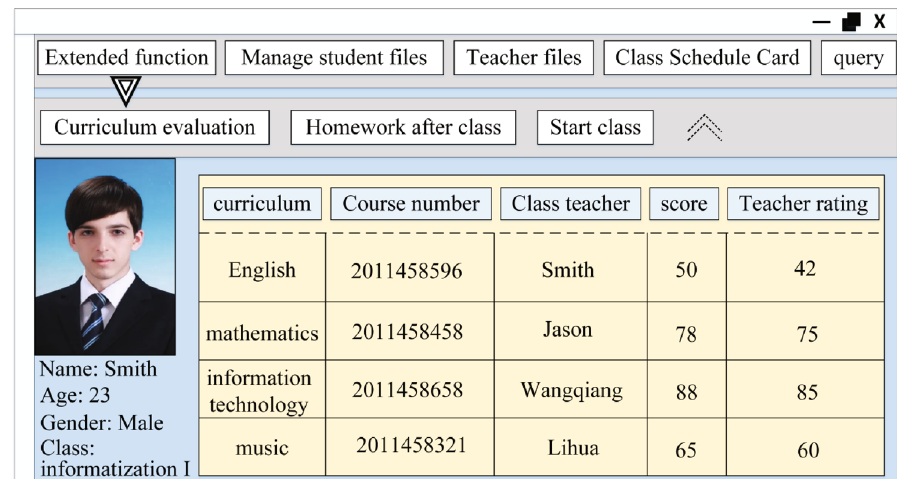
Figure 7: Main functional blocks and system page diagram.